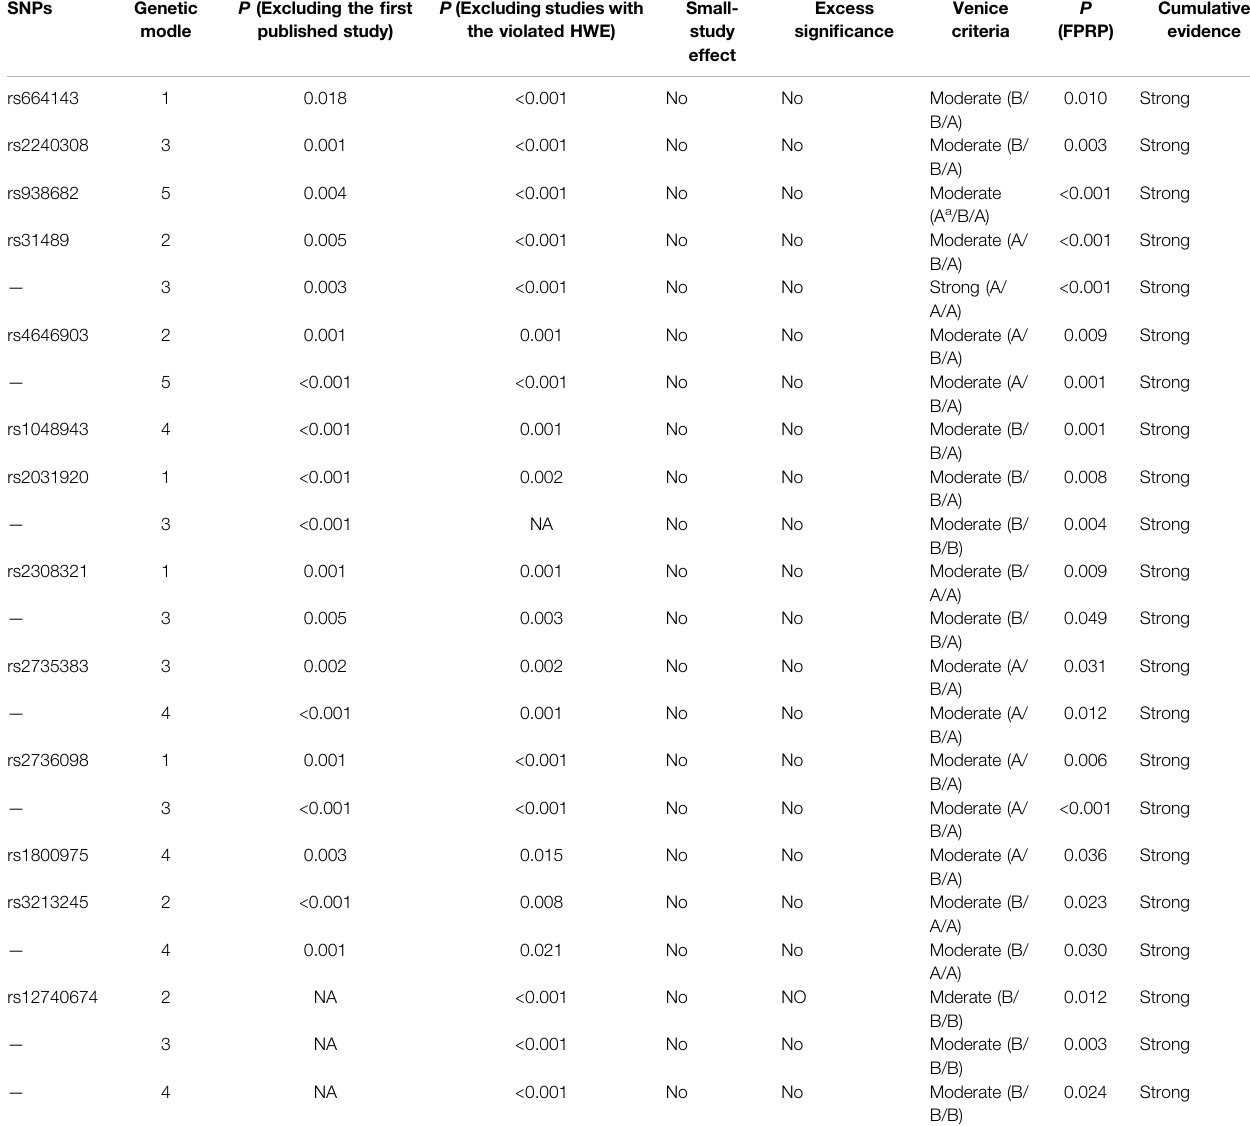
TABLE 3 | Cumulative evidence details of SNPs with the strong cumulative evidence based on the Venice criteria and FPRP. SNPs Genetic